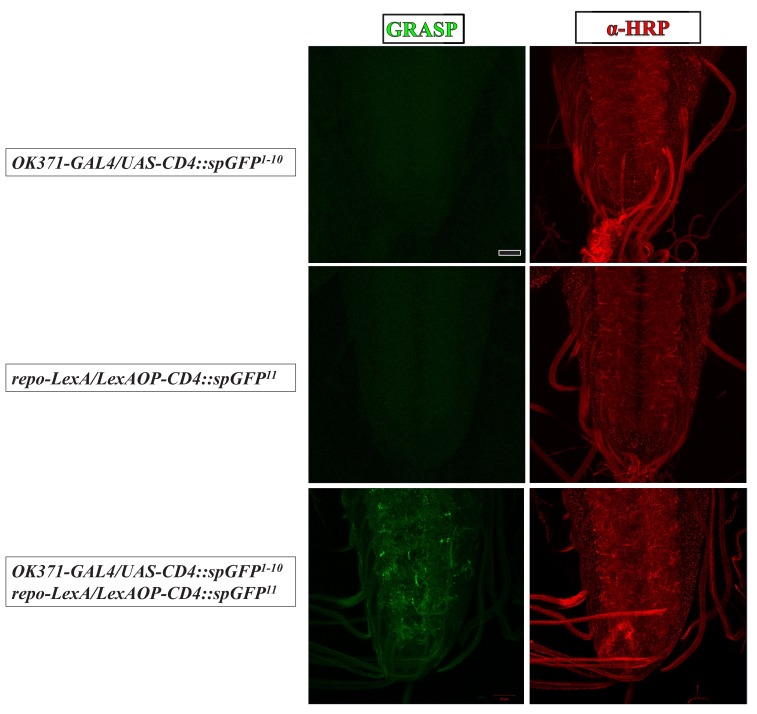
GRASP assay for the physical contact between astrocyte-like glia and glutamatergic neurons.Confocal z-projection images of the VNCs of third instar larvae of the indicated genotypes. GRASP signals (green) are enriched in neuropils (bottom panel), which do not appear in either control, OK371-GAL4/UAS-CD4::spGFP1-10 or repo-LexA/LexAOP2-CD4::spGFP11 (top and middle panels). The VNCs were co-stained with α-HRP (red). Scale bar is 20 μm.